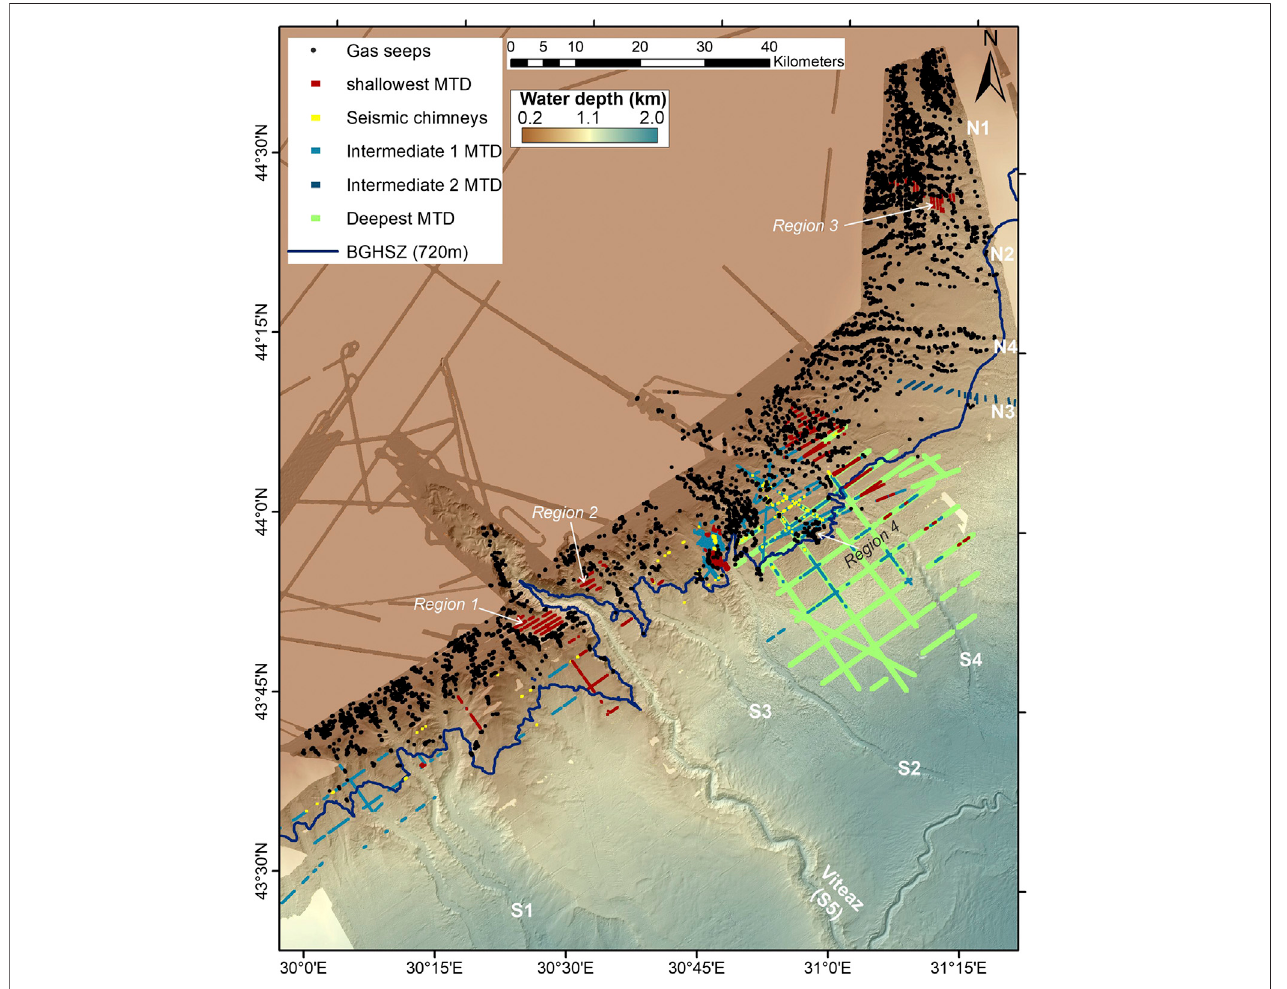
FIGURE11| Overviewofmass-transportdeposits(MTDs)withintheuppermost ∼ 100 mbelowsea fl oorcorrelatingtooccurrencesofgasventsites.Threeregions devoid of vents are linked to recent mass-transport deposits and sea fl oor failure (Regions 1 – 3). In the central region between the S2 and S4 channel, up to three MTDs are stacked. Here, the highest density of seismic chimneys (vertical columns of gas accumulation, Hillman et al., 2018a) are observed (Region 4).